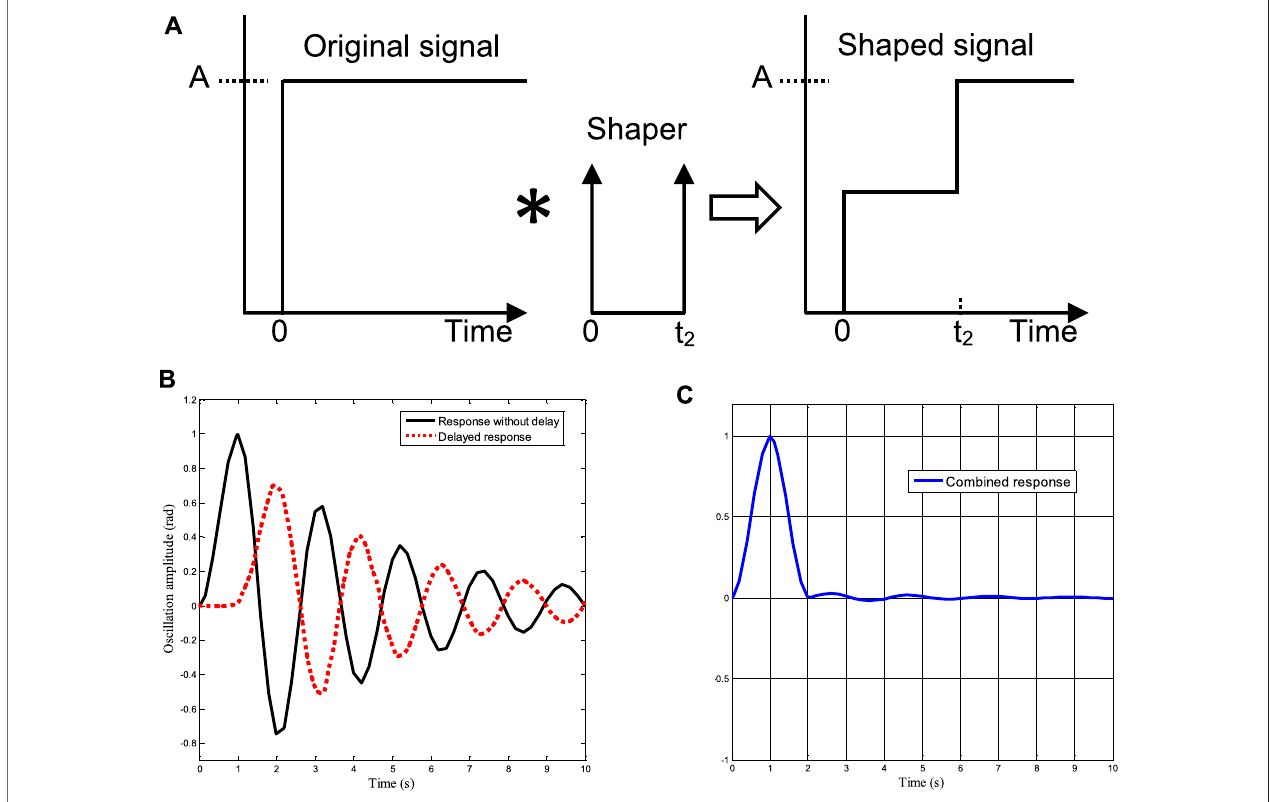
FIGURE 4 | The process of time delay control: (A) Block diagram; (B) Convolution of two responses; (C) Resulting cancelled oscillation.